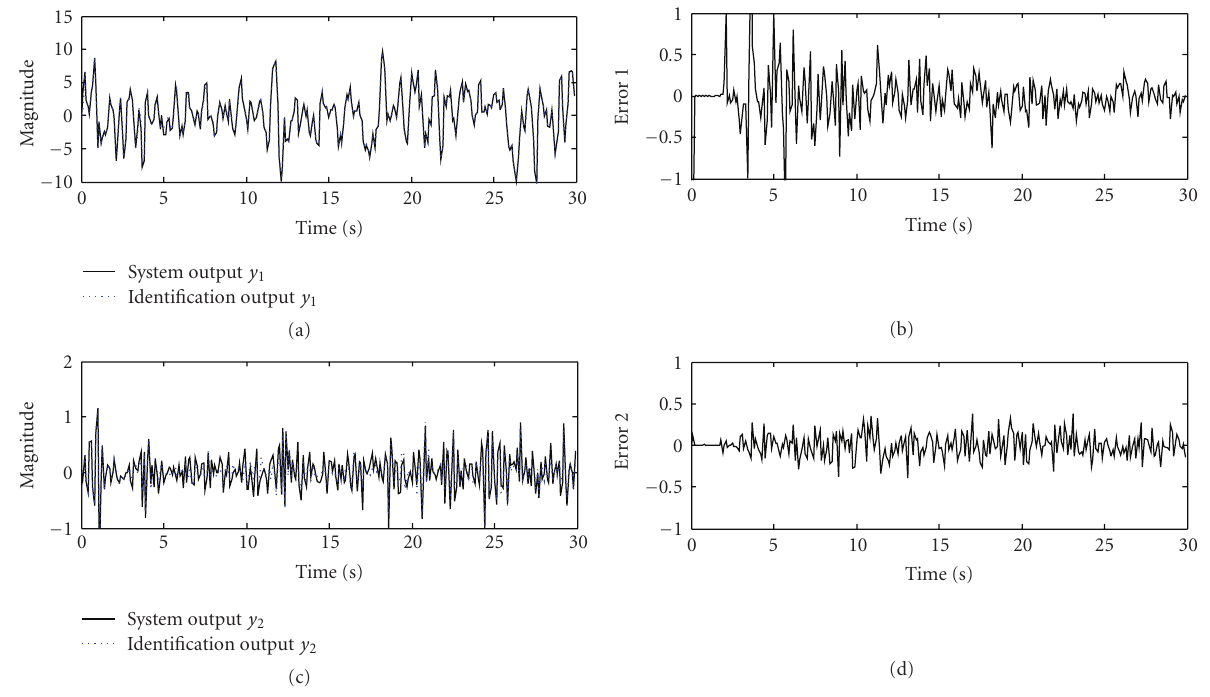
Figure 7: The trajectories of outputs using RELS method without OKID.